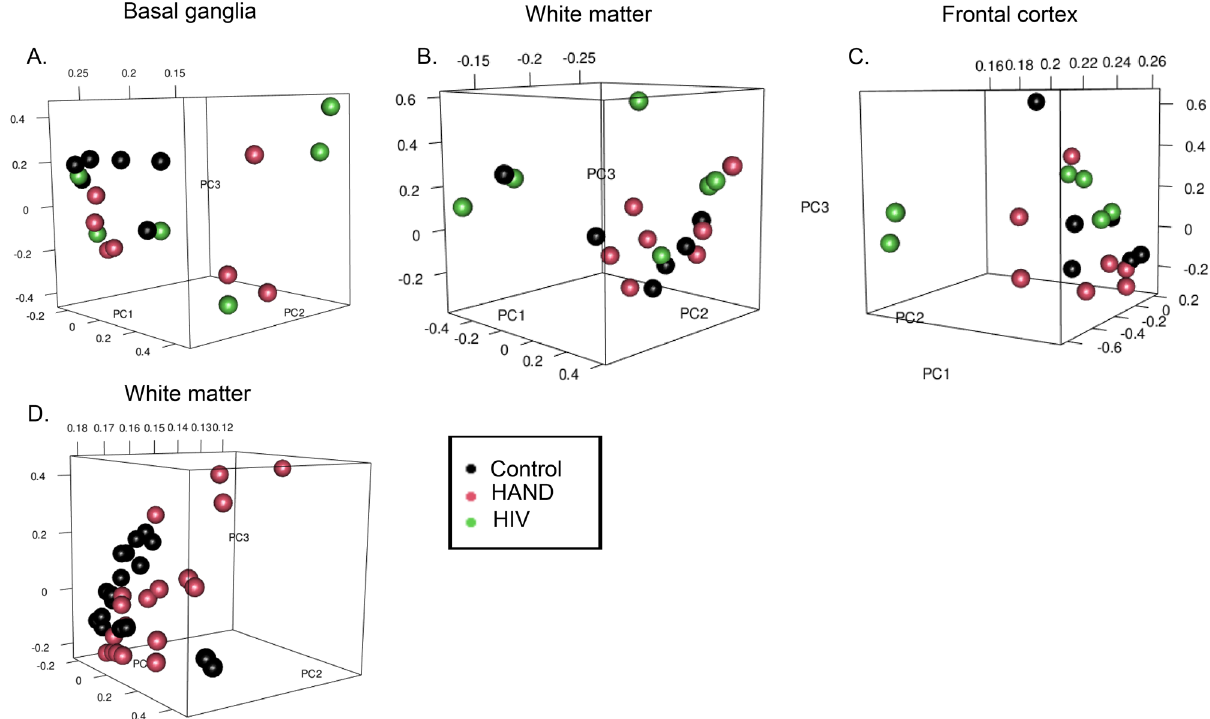
Figure 6. Principal component analysis on HAND patients data. Principal Component Analysis of the controls and other 3 HIV-1 patient groups within the three brain regions, basal ganglia, frontal cortex, and white matter. ( A – C ) showed no clear groupings among the different subject groups from data derived from GSE35864. ( D ) represents untreated HAND data from